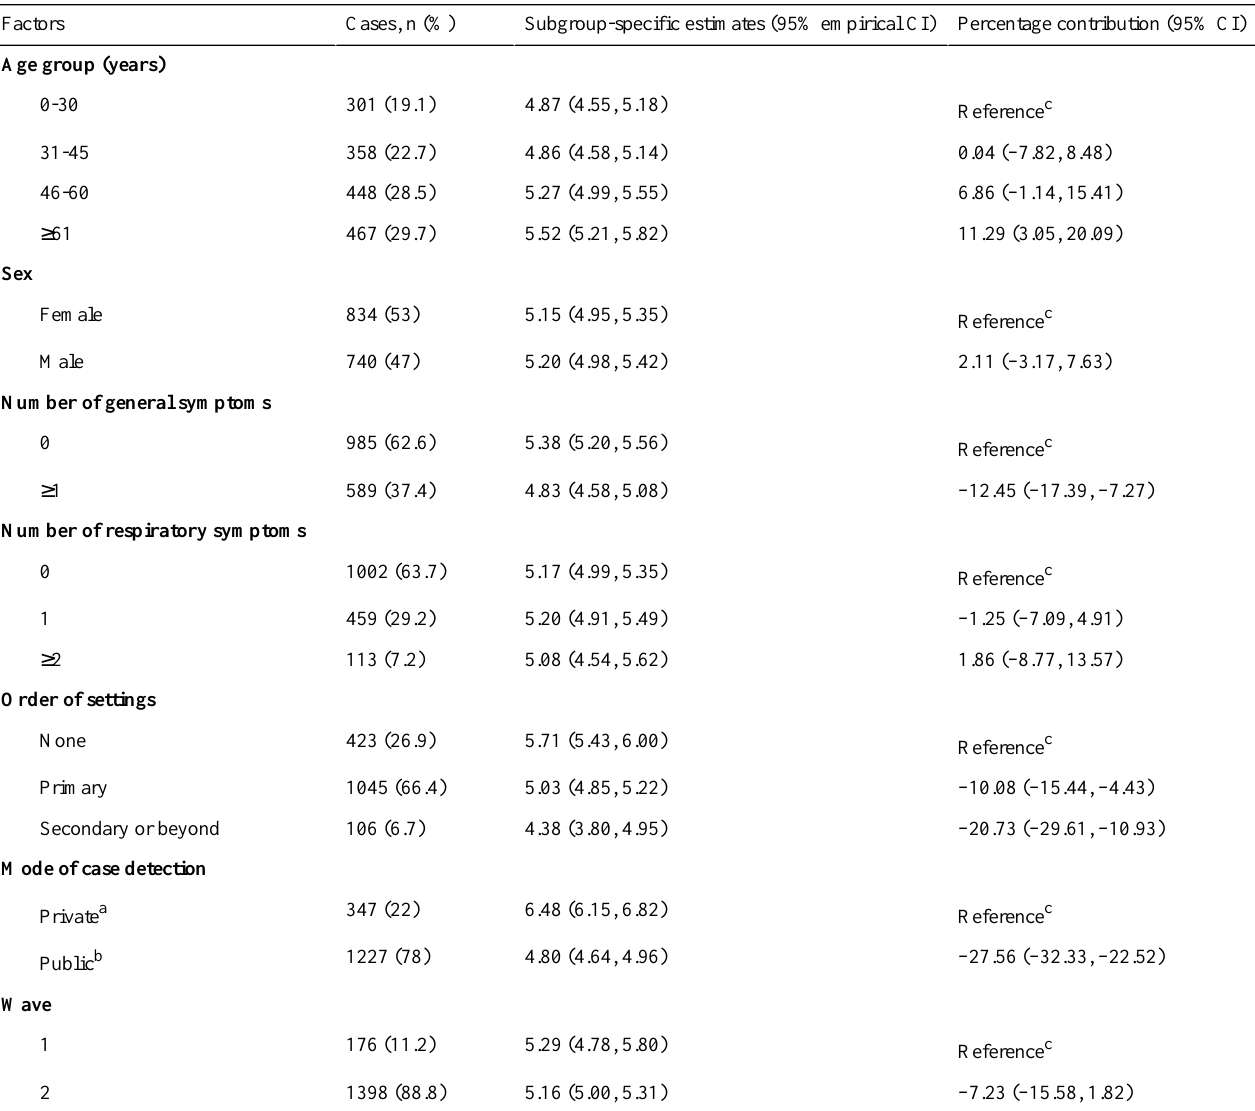
Table 3. Estimates of and factors associated with containment delay based on 1574